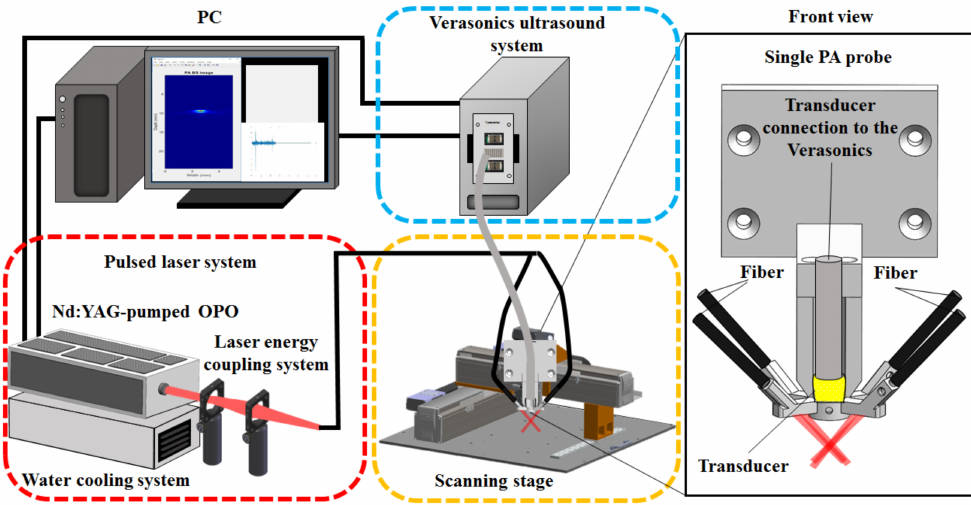
Figure 1. Schematic diagram of the adjustable dark-field AR dual-modality US/PA imaging system with fiber bundle-based